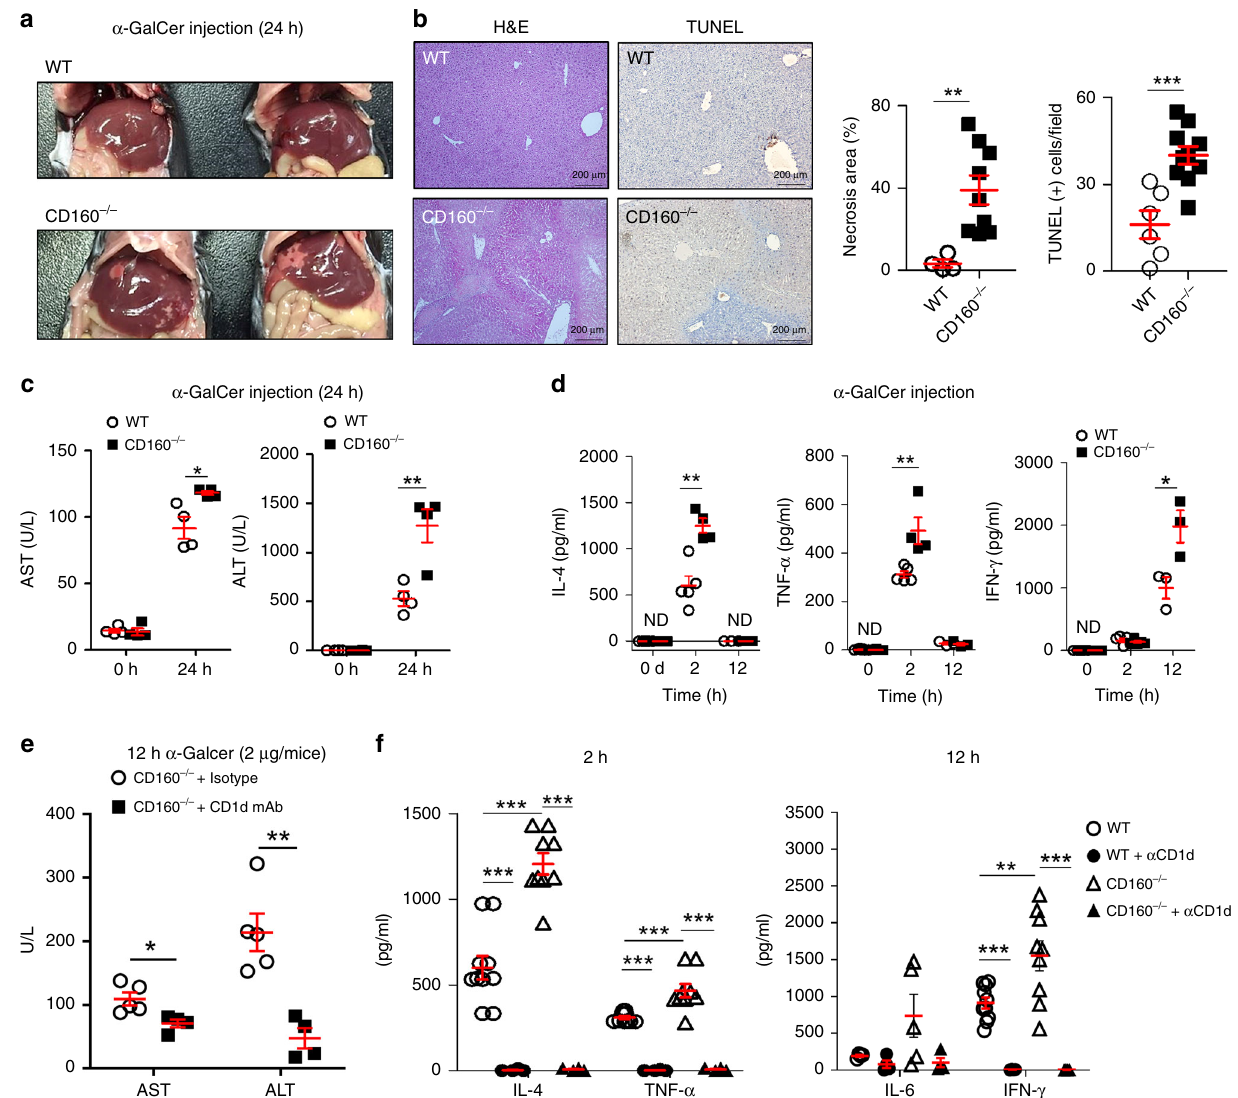
Fig. 3 CD160 − / − mice are more susceptible to α -GalCer-induced liver injury. a Representative images of livers of WT and CD160 − / − mice 24 h following i. p. injection of α -GalCer (2 μ g). b H&E and TUNEL staining of liver sections in WT and CD160 − / − mice. The percentage necrotic area ( n = 4 – 9 per group) and TUNEL ( + ) cells/ fi eld are shown as mean ± S.E.M. (Random area, n = 6 – 10 per group). Scale bars: 200 μ m. c Serum transaminase activity (AST, ALT) 0 and 24 h following i.p. injection of α -GalCer (2 μ g). Data are presented as mean ± S.E.M. ( n = 4 per group). d Serum was collected from WT and CD160 − / − mice at different time points following 2 μ g of α -GalCer injection and cytokines measured by CBA (ND, not detected). Results